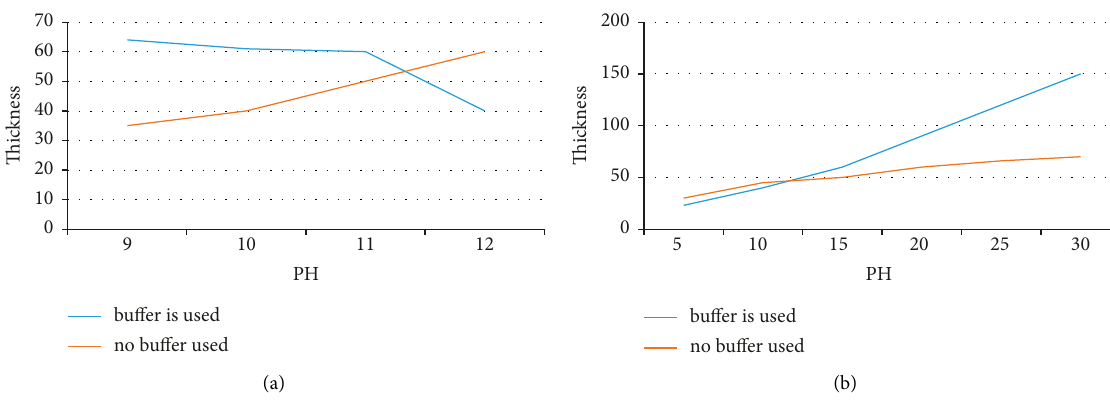
Figure 5: Effect of adding buffer or